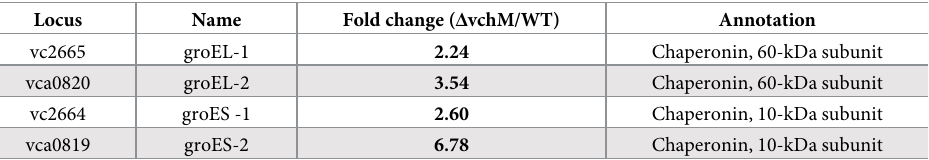
Table 2. Protein folding and stabilization genes upregulated in Δ vchM (fold change > 2, p-value < 0.01).